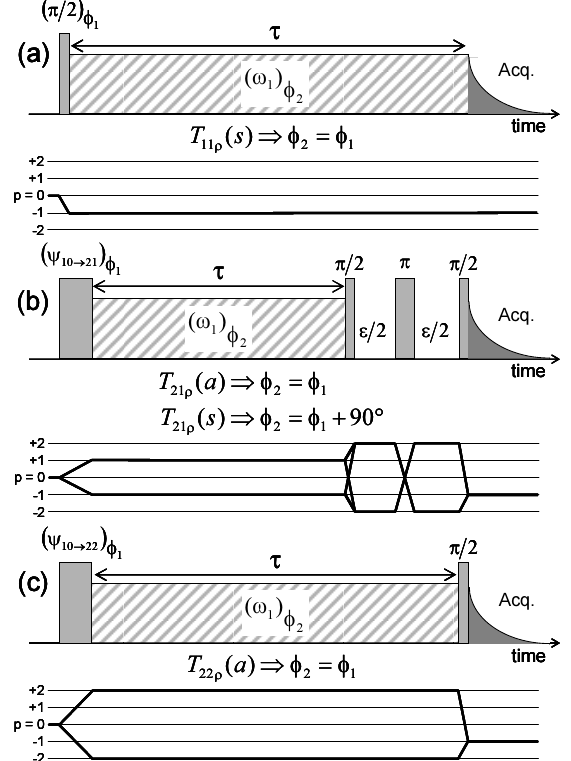
Figure 8. Pulse sequences and coherences transfer pathways used to measure the multi-quanta spin-locking relaxation rates of the ( a ) T 11 ( s ) ; ( b ) T 21 ( a ) and T 21 ( s ) ; and ( c ) T 22 ( a ) coherences, noted T 11 ρ ( s ) , T 21 ρ ( a ) , T 21 ρ ( s ) and T 22 ρ ( a ) respectively. The delay (cid:101) is set equal to 10 µ s. The pulse durations ψ 10 → 21 and ψ 10 → 22 are selected to optimise magnetisation transfer between the corresponding coherences; i.e., T 10 → T 21 and T 10 → T 22 respectively. Reprinted with permission from [23]. Copyright (2014) American Chemical Figure aout 2013 OK, format image metafichier